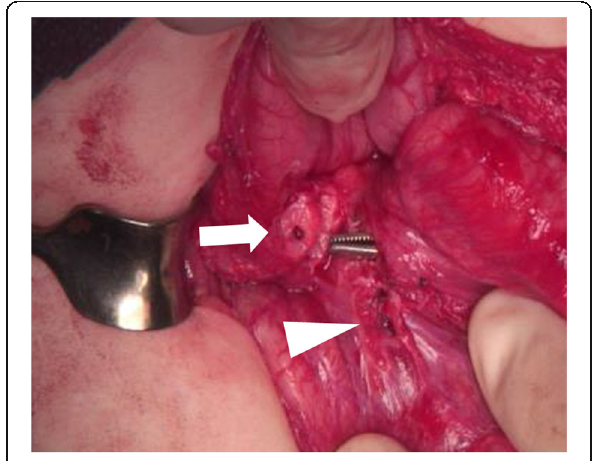
Fig. 2 Intra-operative view, case 1. The white triangle indicates the hemorrhage point. The white arrow indicates ectopic pancreatic tissue with a small